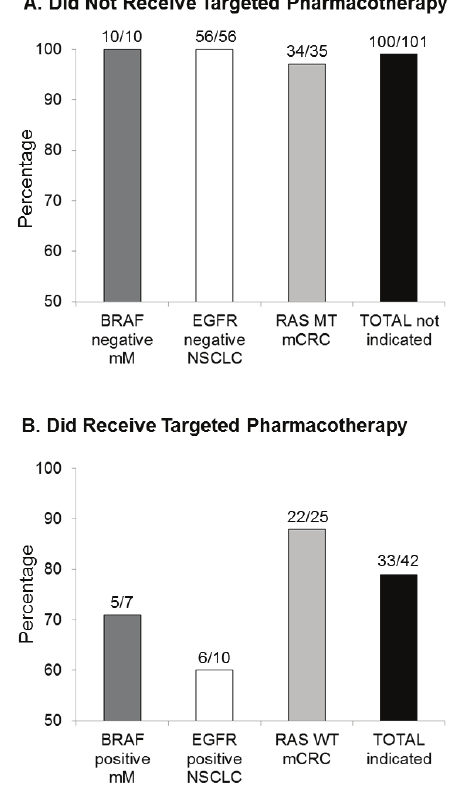
Figure 2. Percentage of patients who ( A ) did not receive targeted pharmacotherapy or ( B ) did receive targeted pharmacotherapy according to NCCN guidelines after OncoFOCUS™+ KIT screening